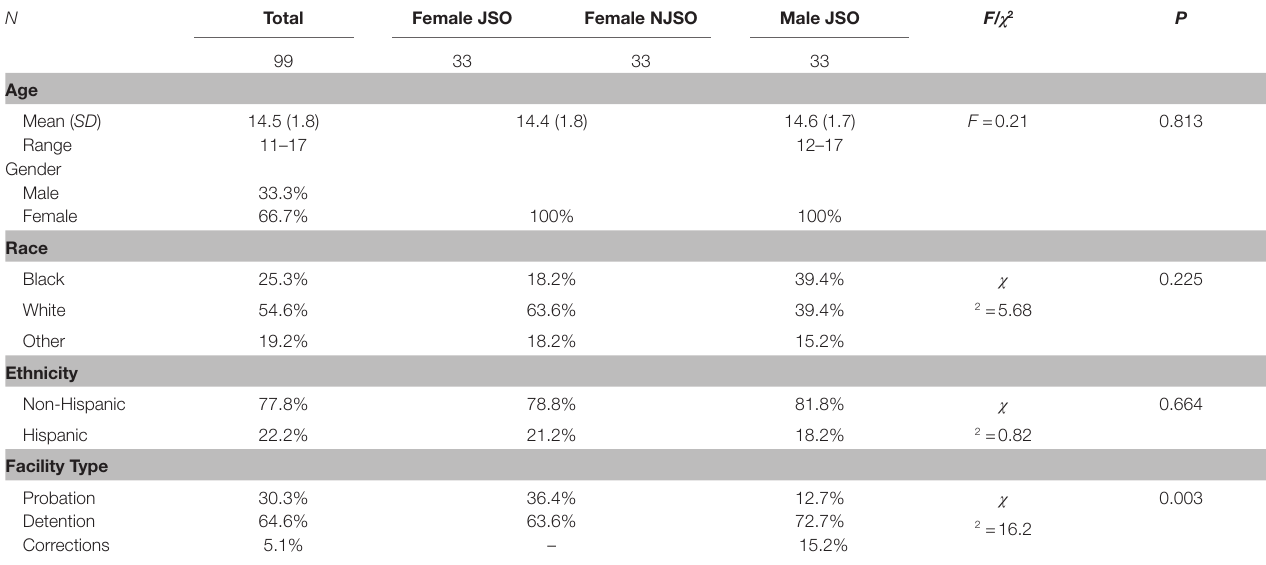
TABLE 1 | General Descriptives.